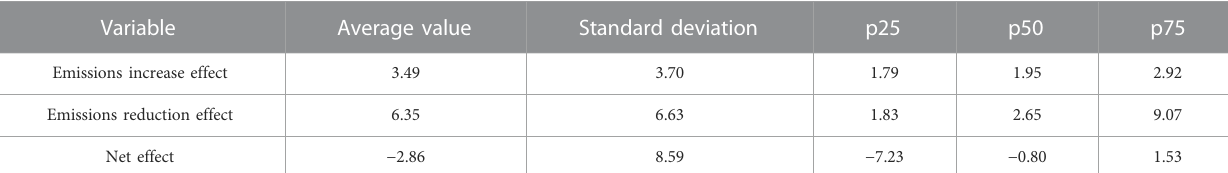
TABLE 10 Degree of deviation in air pollution (%) due to the digital economy impact